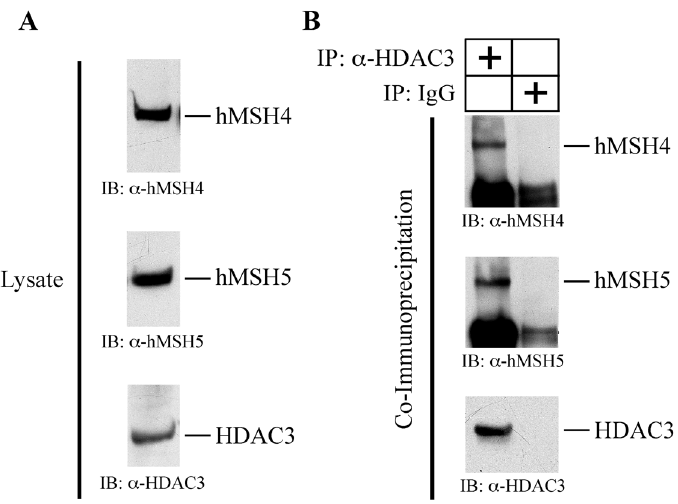
Figure 5. Co-existence of hMSH4 and HDAC3 in the same protein complex in